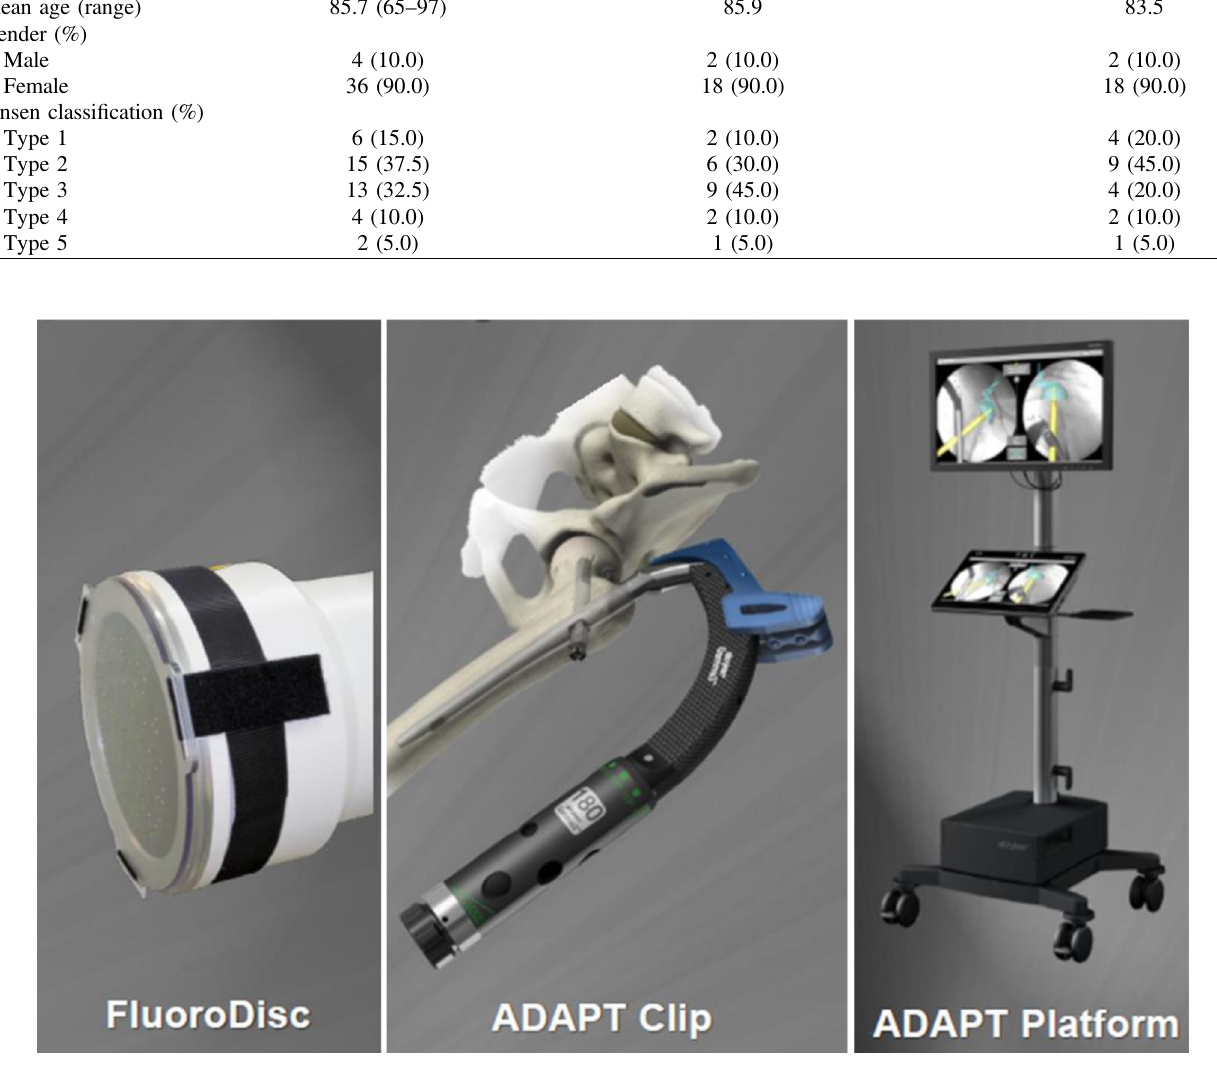
Figure 1. FluoroDisc of ADAPT – C-arm tube with FluoroDisc with position markers. ADAPT Clip – An ADAPT clip with an integrated position marker is attached to the Gamma3 targeting device. ADAPT Platform – ADAPT Platform detects and displays the position of the screw according to the positional